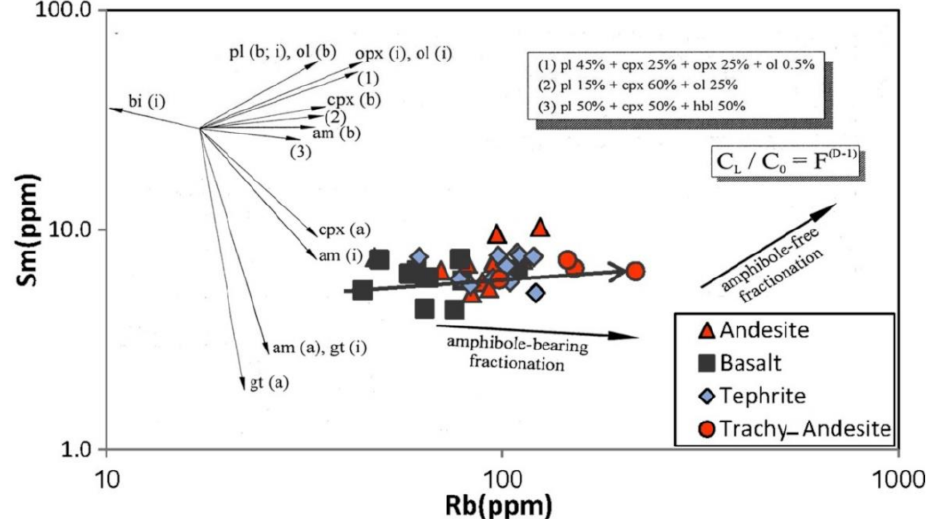
Figure 14. Sm against Rb log–log diagram showing theoretical fractionation vectors modelled for crys- tallization of individual mineral phases and phase assemblages. Phase combinations are presented in inset. Theoretical vectors are for 50% crystallization of single phases and phase